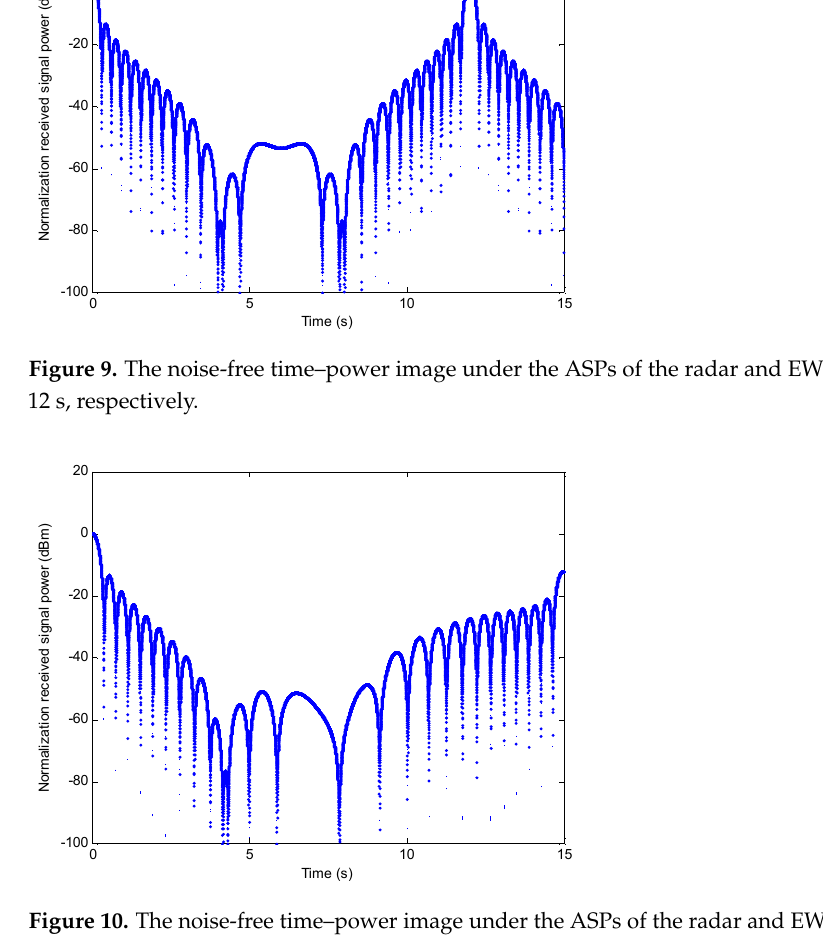
Figure 10. The noise-free time–power image under the ASPs of the radar and EW system of 12 s and 15 s, respectively.